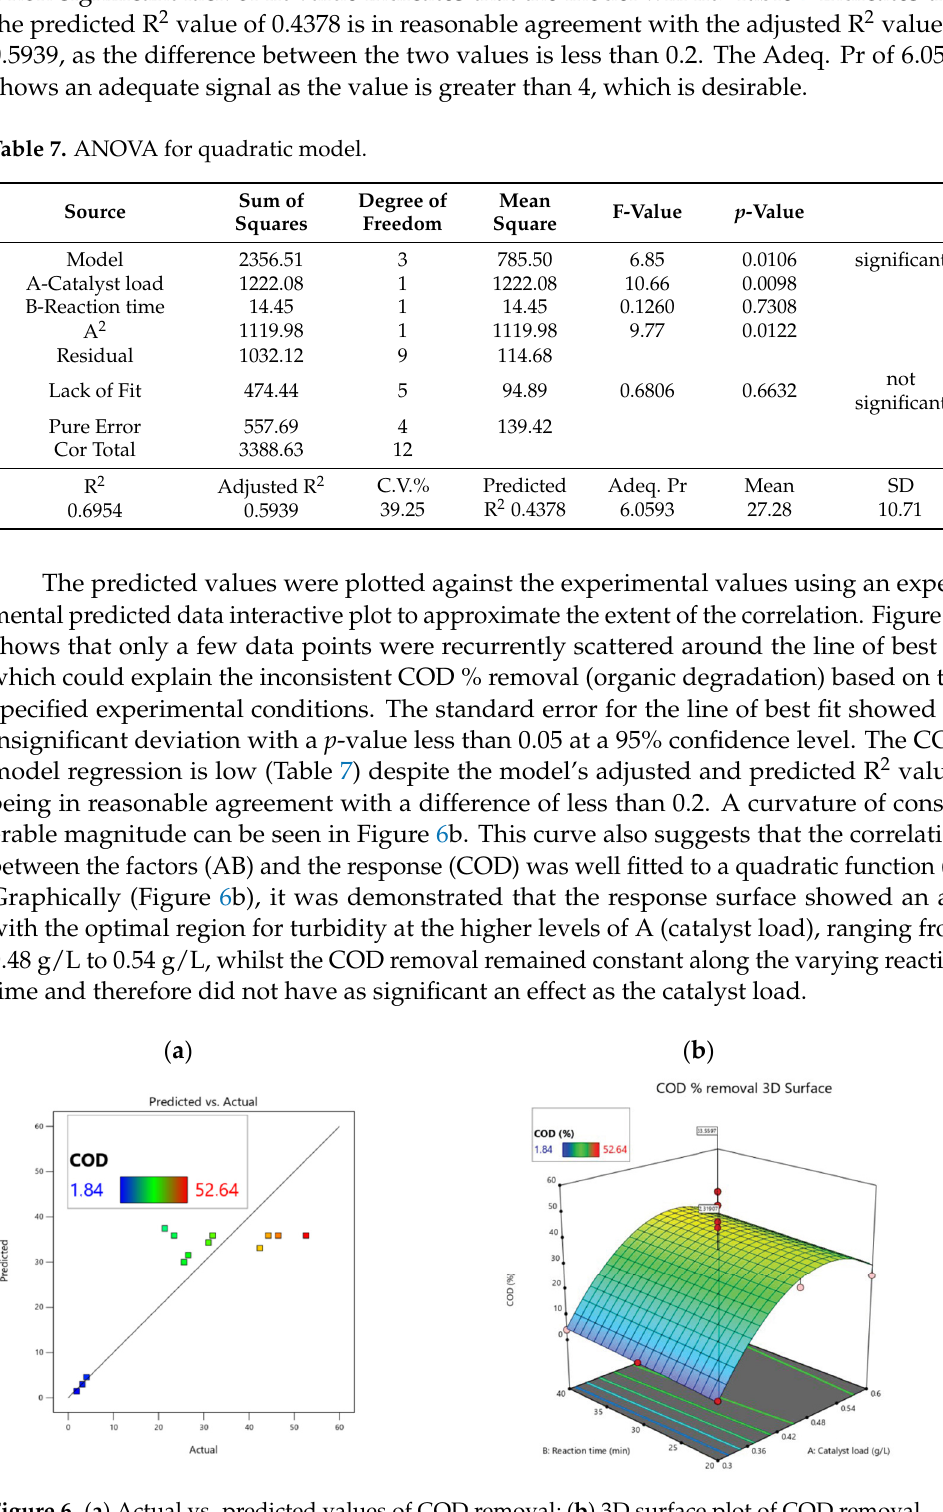
Figure 6. ( a ) Actual vs. predicted values of COD removal; ( b ) 3D surface plot of COD removal. COD = 35.88 + 14.27 𝐴 + 1.55 𝐵 − 18.62 𝐴 2